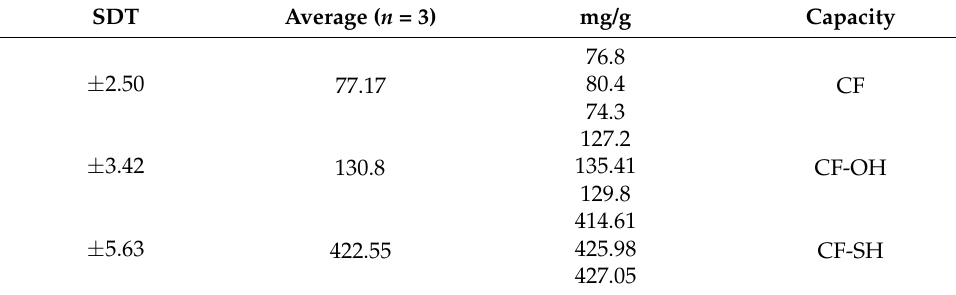
Table 3. Capacity of CFs (mg Hg/g CF or CF-OH or CF-SH). SDT Average ( n = 3) mg/g